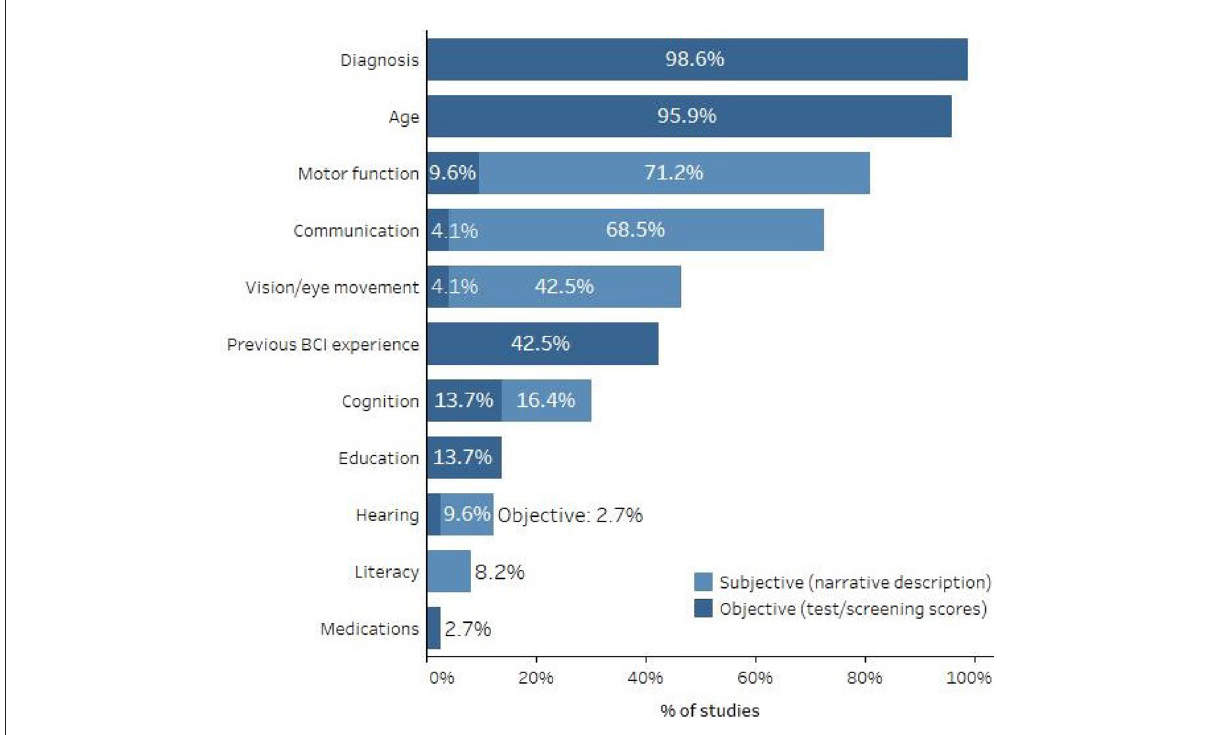
FIGURE6 Percent of studies that described various participant